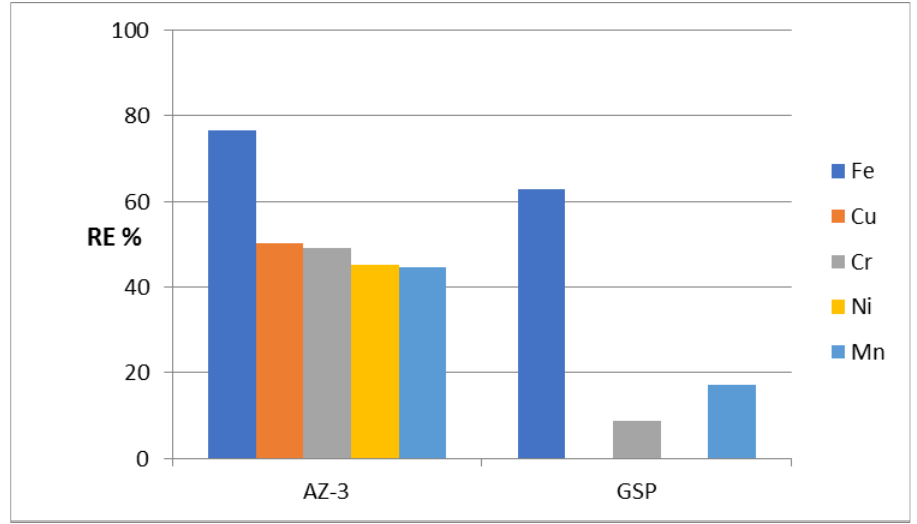
Figure 10. The removal percentage of heavy metals from water in an extremely acidic medium for the AZ-3 and GreensandPlus